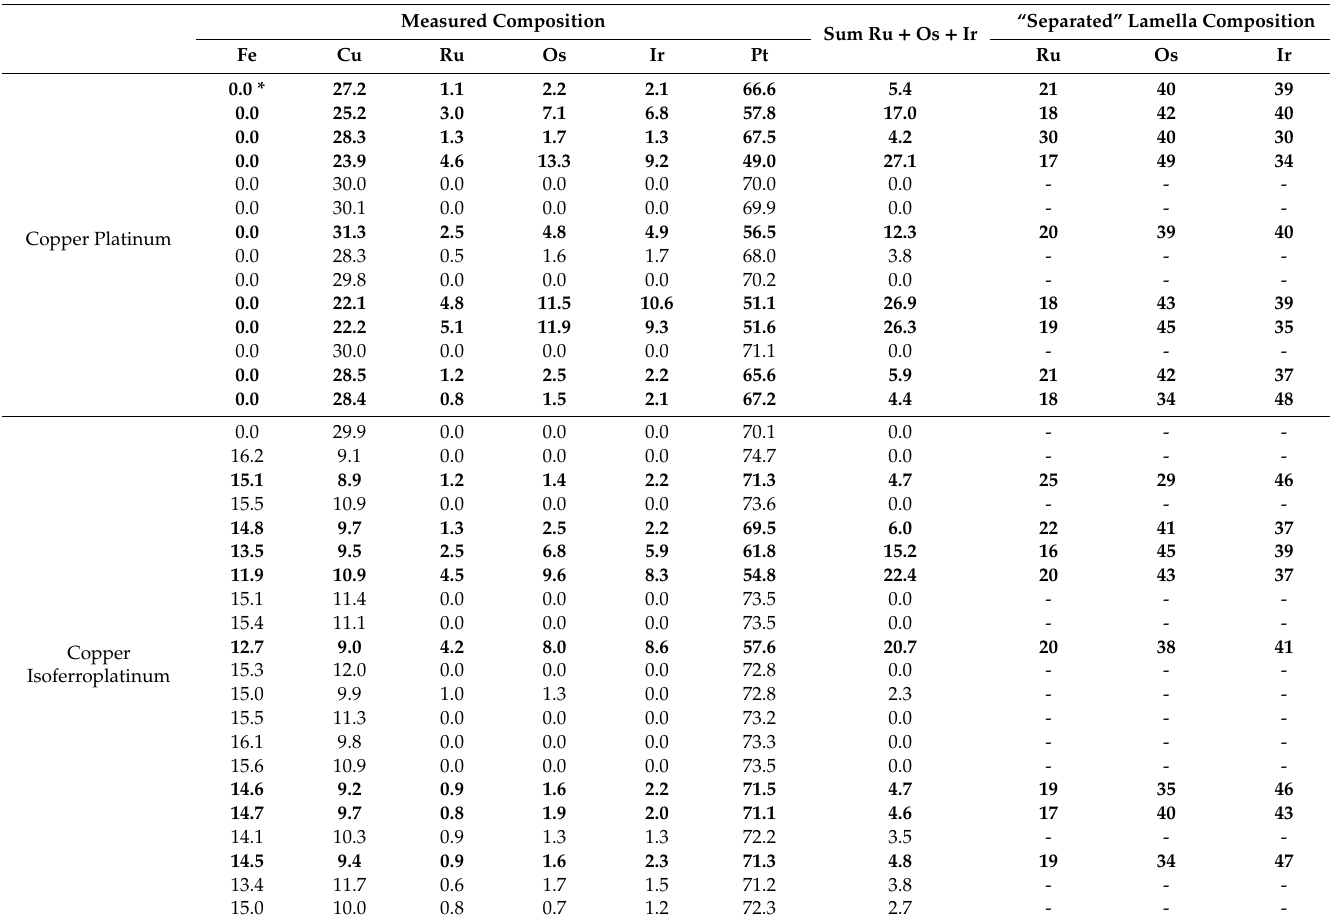
Table 3. Composition of copper platinum and copper isoferroplatinum of grain No. 1, “pure”, with micro-inclusions of Ru-Os-Ir lamellae and “separated” composition of lamellae, according to SEM-EDS analysis,